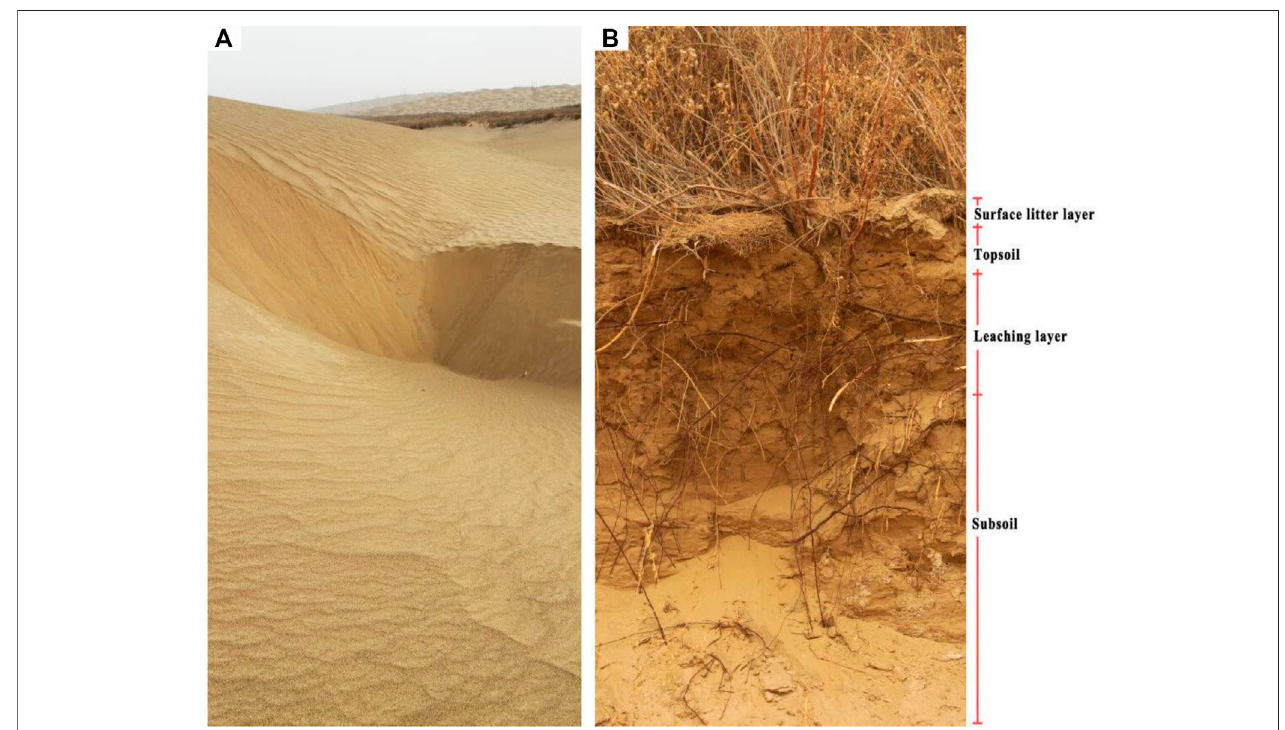
FIGURE 8 | Strati fi cation of soil of shifting sands before the shelterbelt has been built in 1990 (A) and that under the shelterbelt (B) in 2021.